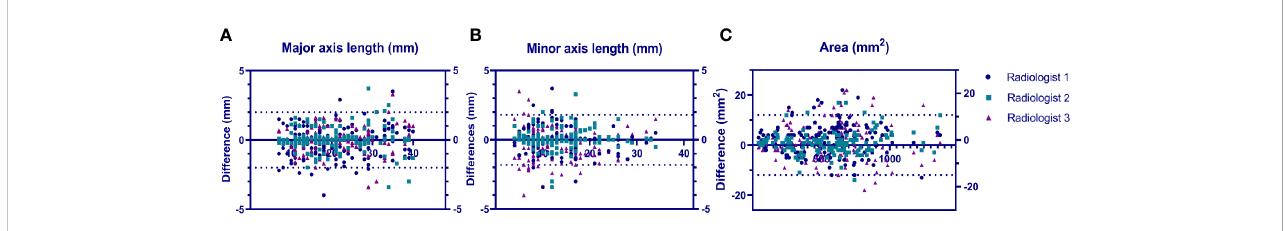
FIGURE 7 Bland – Altmann plots showing the model performance vs. that of each radiologist in terms of lesion major axis length (A) , lesion minor axis length (B) and lesion area (C) .uts a US image and a segmented SWE image at the same time.